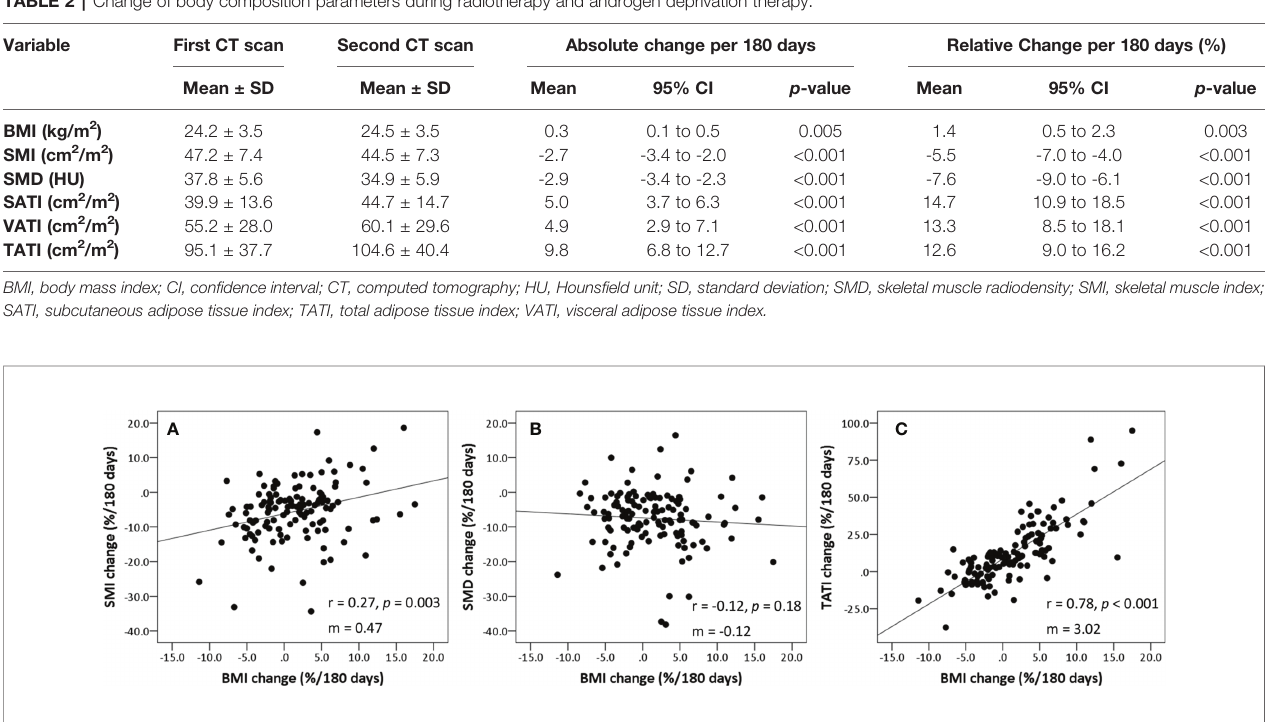
FIGURE 2 | Scatter plots showing correlation between the changes in BMI, SMI, SMD, and TATI. (A) SMI vs . BMI, (B) SMD vs . BMI, and (C) TATI vs . BMI. Spearman ’ s rank correlation coef fi cient (rho) was used to assess correlation between body composition parameters. Slopes (m) for the correlations are shown on each graph. BMI, body mass index; SMD, skeletal muscle radiodensity; SMI, skeletal muscle index; TATI, total adipose tissue